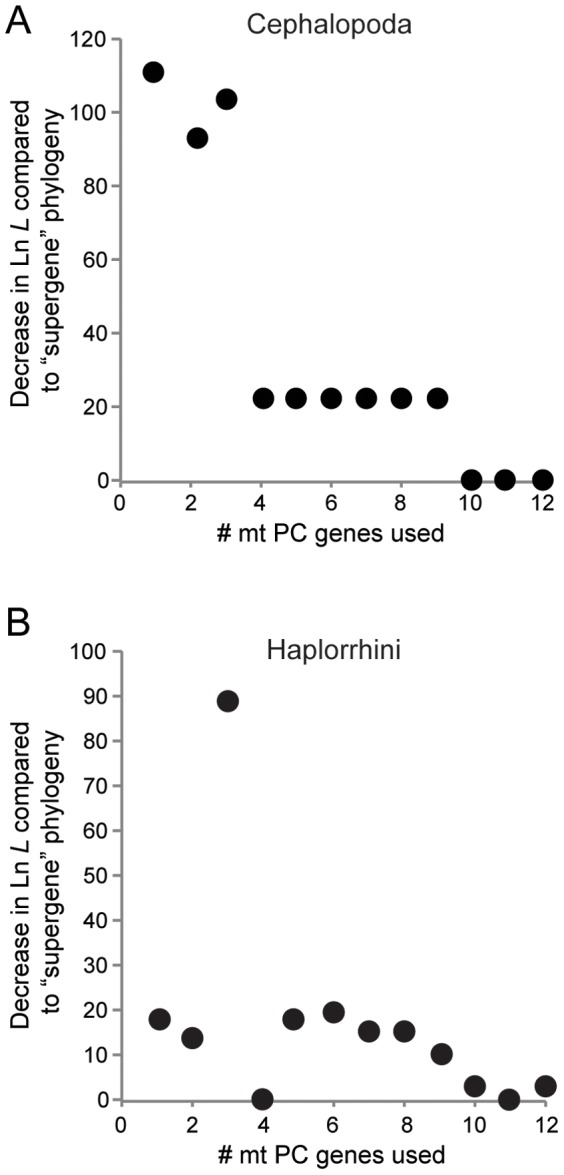
Examples demonstrating instances where the minimum number of mt protein-coding (PC) genes is either apparent or ambiguous.A) A phylogeny for the Cephalopoda where the number of mt protein-coding (PC) genes minimally required to infer a statistically indistinguishable topology to that of the “supergene” set (i.e., all 13 mt PC genes) is apparent. Shimodaira-Hasegawa (SH) tests indicated a minimum of four genes as being needed. The break is clearly indicated by the large decrease in Ln L compared to the “supergene” phylogeny when utilizing less than four genes or when utilizing four or more genes. This trend was typical for the majority of lineages examined (93.5% and 93.0% when utilizing amino acid and nucleotide data, respectively). B) A phylogeny for the Haplorrhini where the number of mt protein-coding (PC) genes minimally required to infer a statistically indistinguishable topology to that of the “supergene” topology is ambiguous. In this case, the SH tests indicated utilizing any combination other than three genes recovered the “supergene” topology, which is indicated by the large decrease in Ln L when just three genes are employed. In these cases, the minimum number of genes that statistically recreated the “supergene” topology was chosen (e.g., a single gene, NAD5, for Haplorrhini). This alternative trend was atypical of the data (6.5% and 7.0% of lineages when utilizing amino acid and nucleotide data, respectively). Comparisons presented in A and B are for phylogenies that utilized amino acid data and were inferred via maximum likelihood.